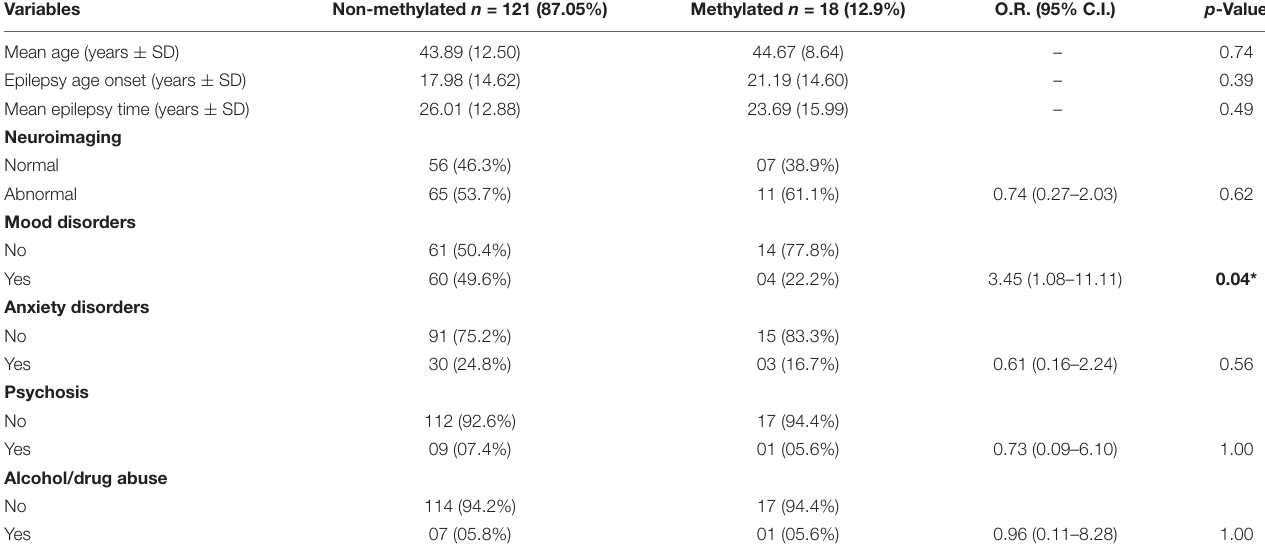
TABLE 3 | Clinical variables according with SLC6A4 and BDNF methylation.